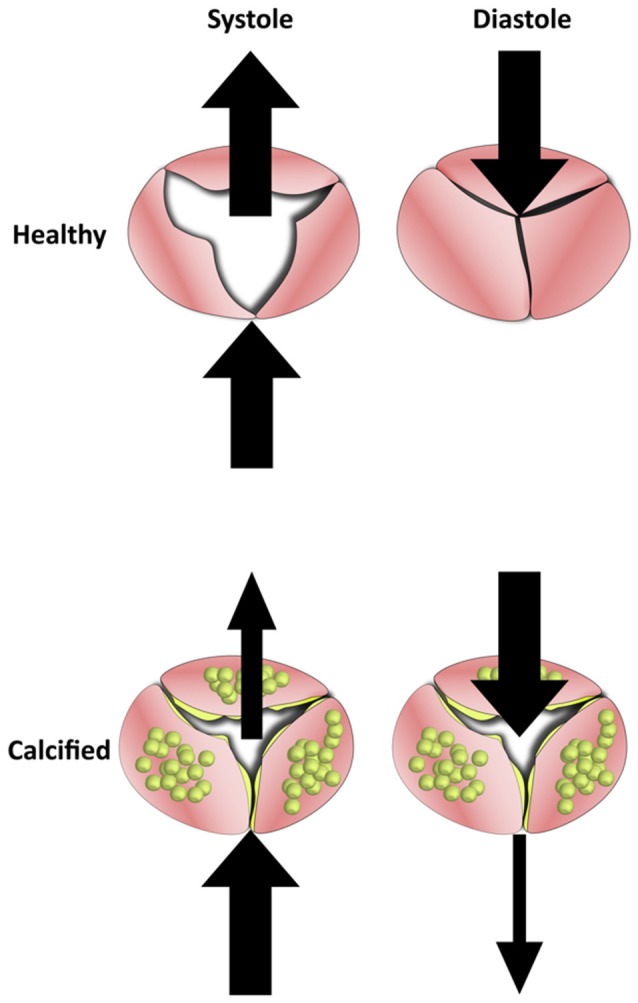
The Effects of calcification on blood flow in the aortic valve. Healthy valve leaflets are able to move according to blood flow which allows them to open completely under systolic forces and coapt under diastolic. In calcified valves, leaflets lose their flexibility and become rigid. This results in valves that can neither open or close fully, which reduces mean ejection fraction and increases regurgitation.